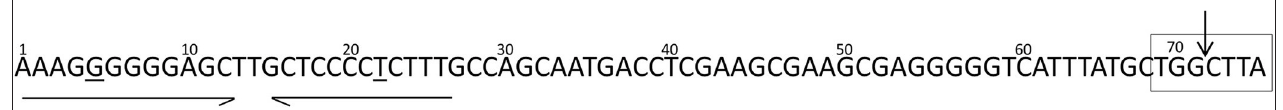
FIGURE 2 | Putative oriT region of pSDH-1. Near-perfect inverted repeats are indicated by arrows. Nucleotide mismatches are underlined. Nucleotides identical to the putative oriT region of ColE1 are boxed and the specific dinucleotide where the relaxase-mediated cleavage occurs ( nic ) in ColE1 is indicated by the arrow.